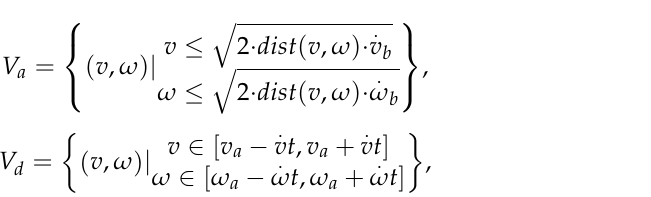
Figure 10. Navigation stack